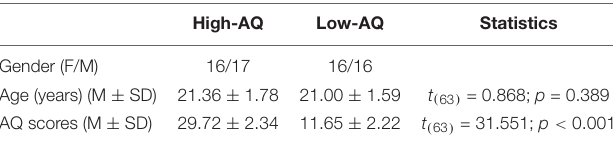
TABLE 3 | Demographic characteristics of the High-AQ and Low-AQ groups in Experiment